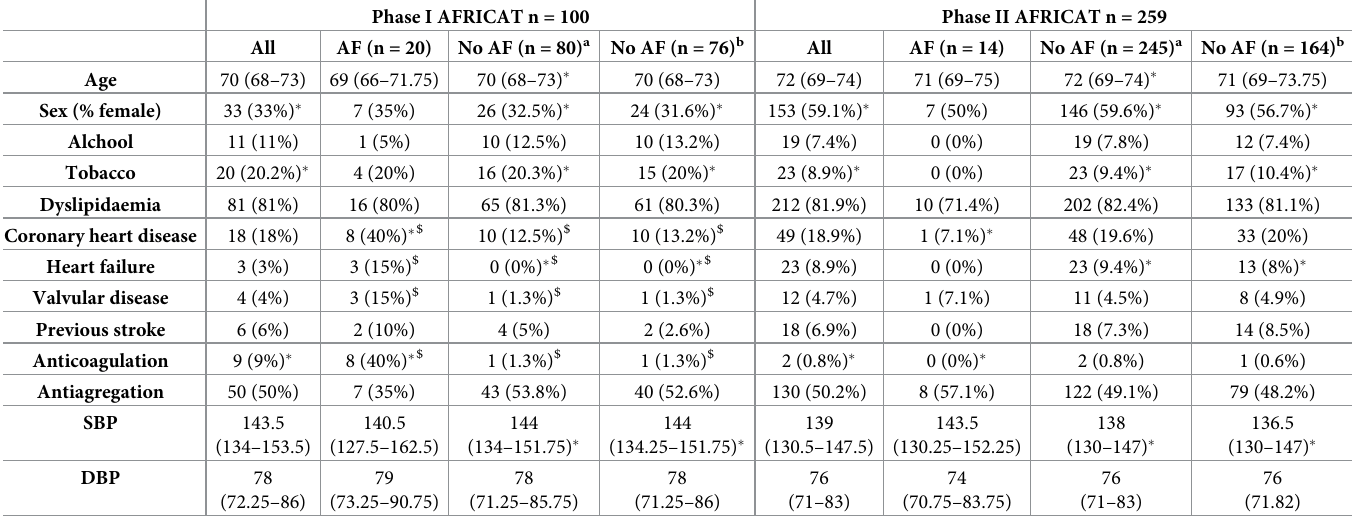
Table 1. Clinical characteristics of the cohort and comparison according to atrial fibrillation diagnosis.